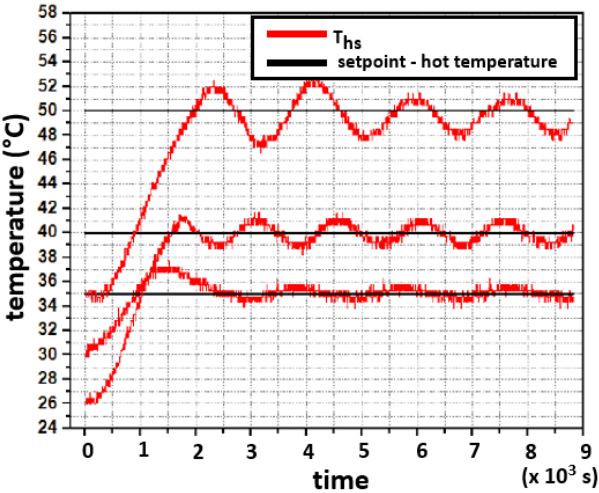
Figure 14. Three testing setpoints for the experimental closed-loop response for the hot